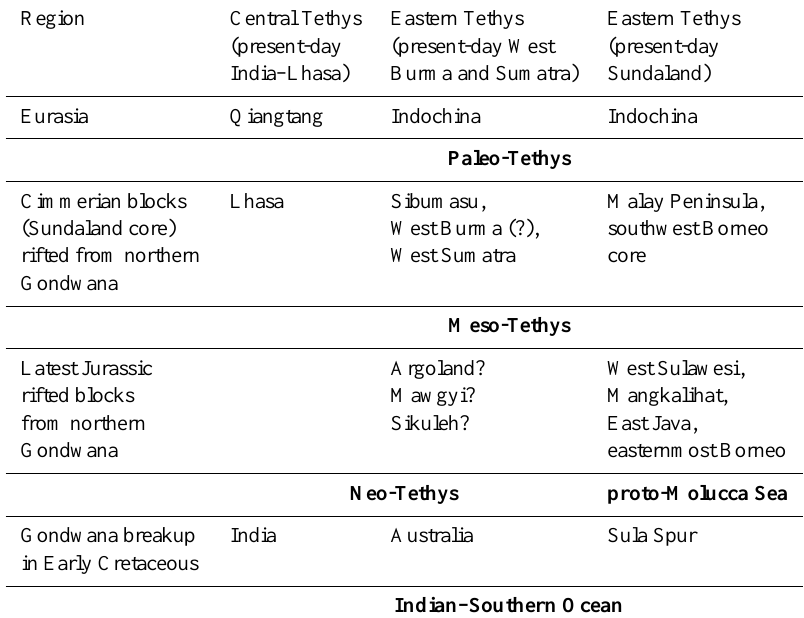
Table 1. Summary of the terrane accretions and nomenclature for the Tethyan oceanic domains used in this study following Seton et al.